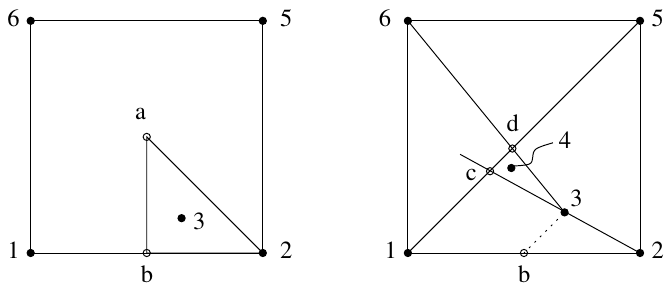
Figure 5. Optimizing the instance C 6 . At the left the positioning of the four convex hull points and the 4 point p 3 . At the right the positioning of point p 4 . Details in the text.